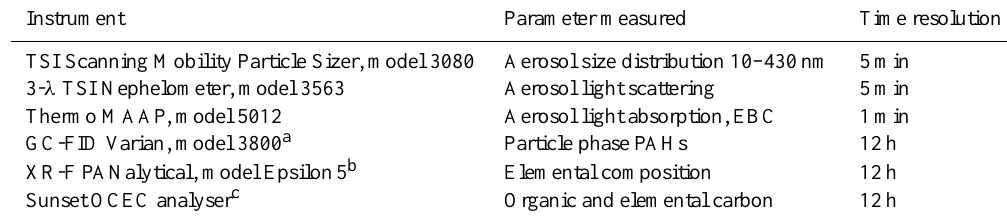
Table 1. List of instrumentation used in this study Instrument Parameter measured Time resolution TSI Scanning Mobility Particle Sizer, model 3080 Aerosol size distribution 10–430nm 5min 3- λ TSI Nephelometer, model 3563 Aerosol light scattering 5min Thermo MAAP, model 5012 Aerosol light absorption, EBC 1min GC-FID Varian, model 3800 a Particle phase PAHs 12h XR-F PANalytical, model Epsilon5 b Elemental composition 12h Sunset OCEC analyser c Organic and elemental carbon